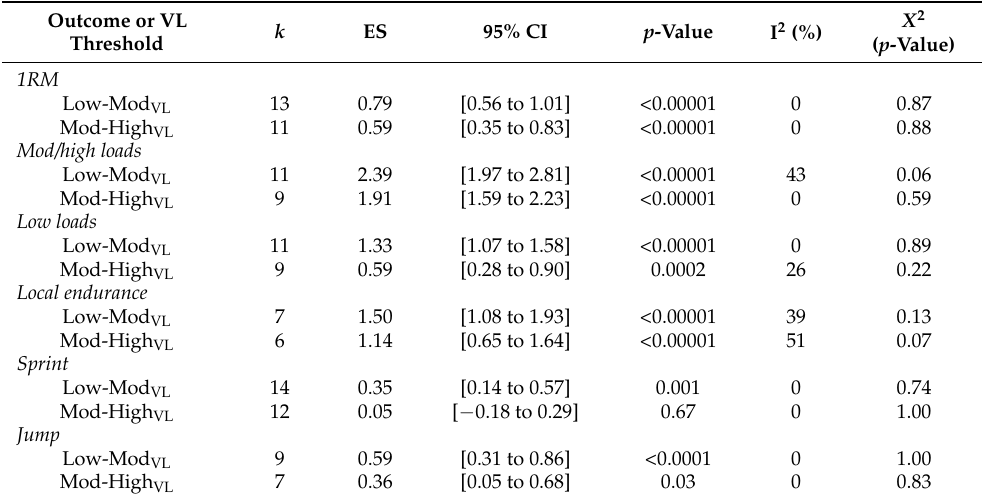
Figure 6. Between-group analysis comparing the effects of Low-Mod VL (≤25% intra -set VL) and Mod-High VL (>25% intra- set VL) to promote changes in sprint capacity. Green squares: ES for each individual comparison; Black diamond: pooled ESs. Sánchez-Moreno et al. [31]; Pareja-Blanco et al. [35,37,38]; Rodríguez-Rosell et al. [34,40].